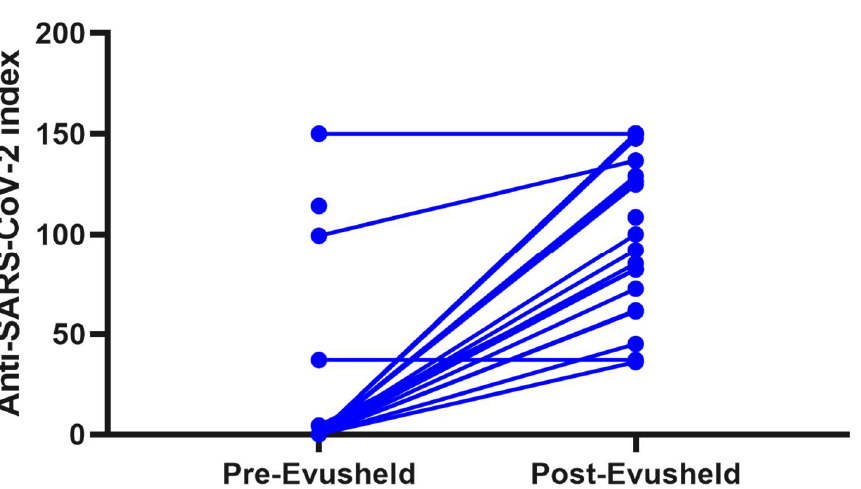
Figure 1. Line plot demonstrating the longitudinal change in anti-SARS-CoV-2 antibodies in pwNID before and after administration of tixagevimab and cilgavimab. Legend: pwNID—patients with neuroinflammatory disorders, a significant response in anti-SARS-CoV-2 antibody levels before and after administration of tixagevimab and cilgavimab in 31 pwNID.